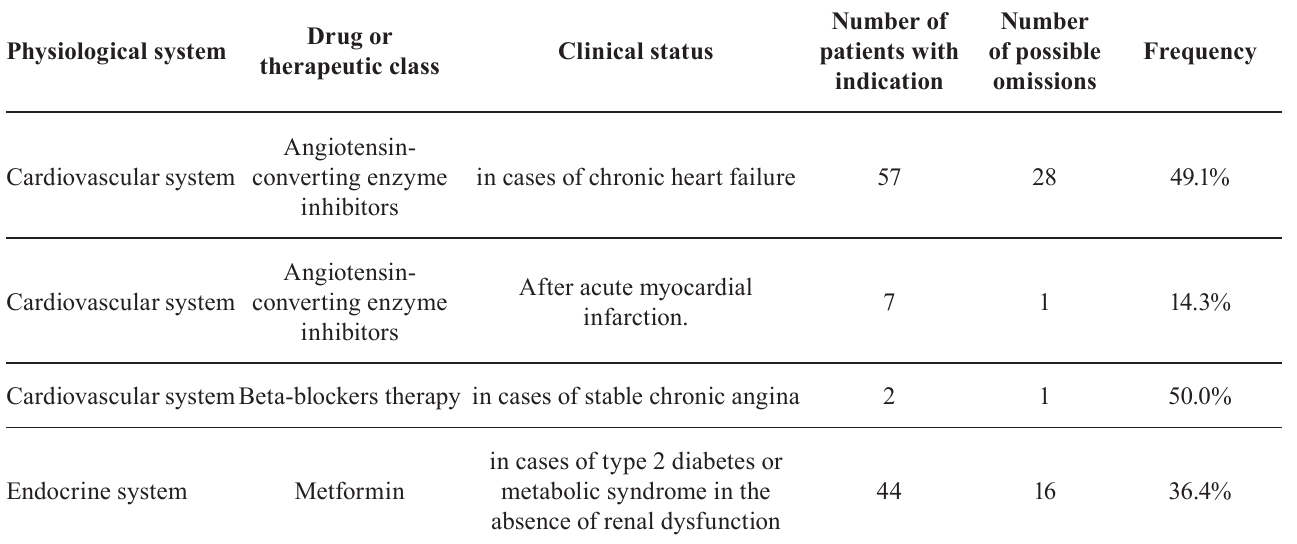
TABLE III – Main drugs or therapeutic classes that presented possible prescribing omissions at hospital discharge, according to the START criteria, validated for the Brazilian